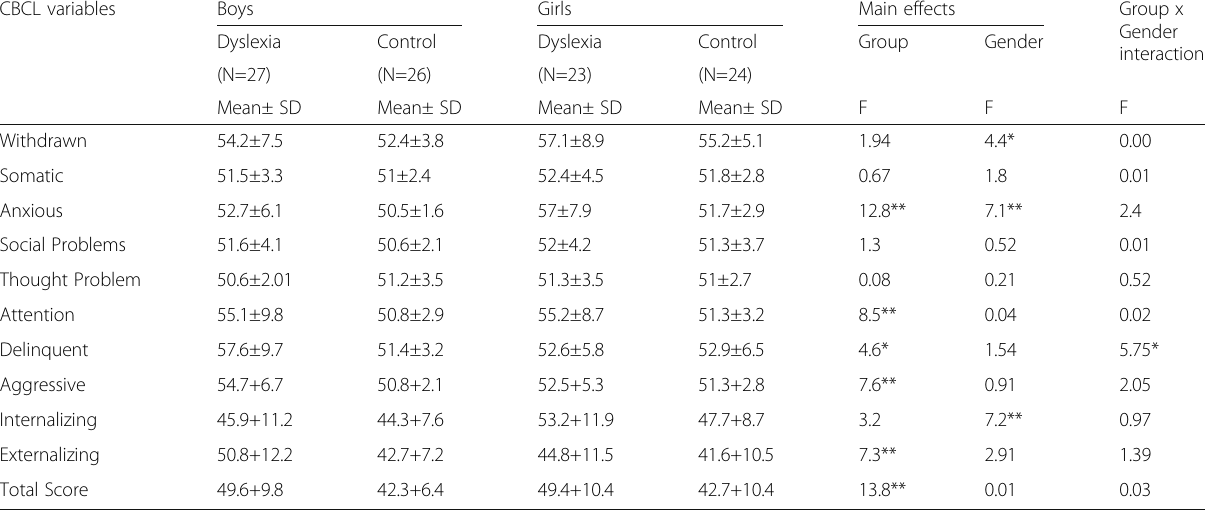
Table 7 Mean scores of boys and girls on measures of Problem Scales of CBCL CBCL variables